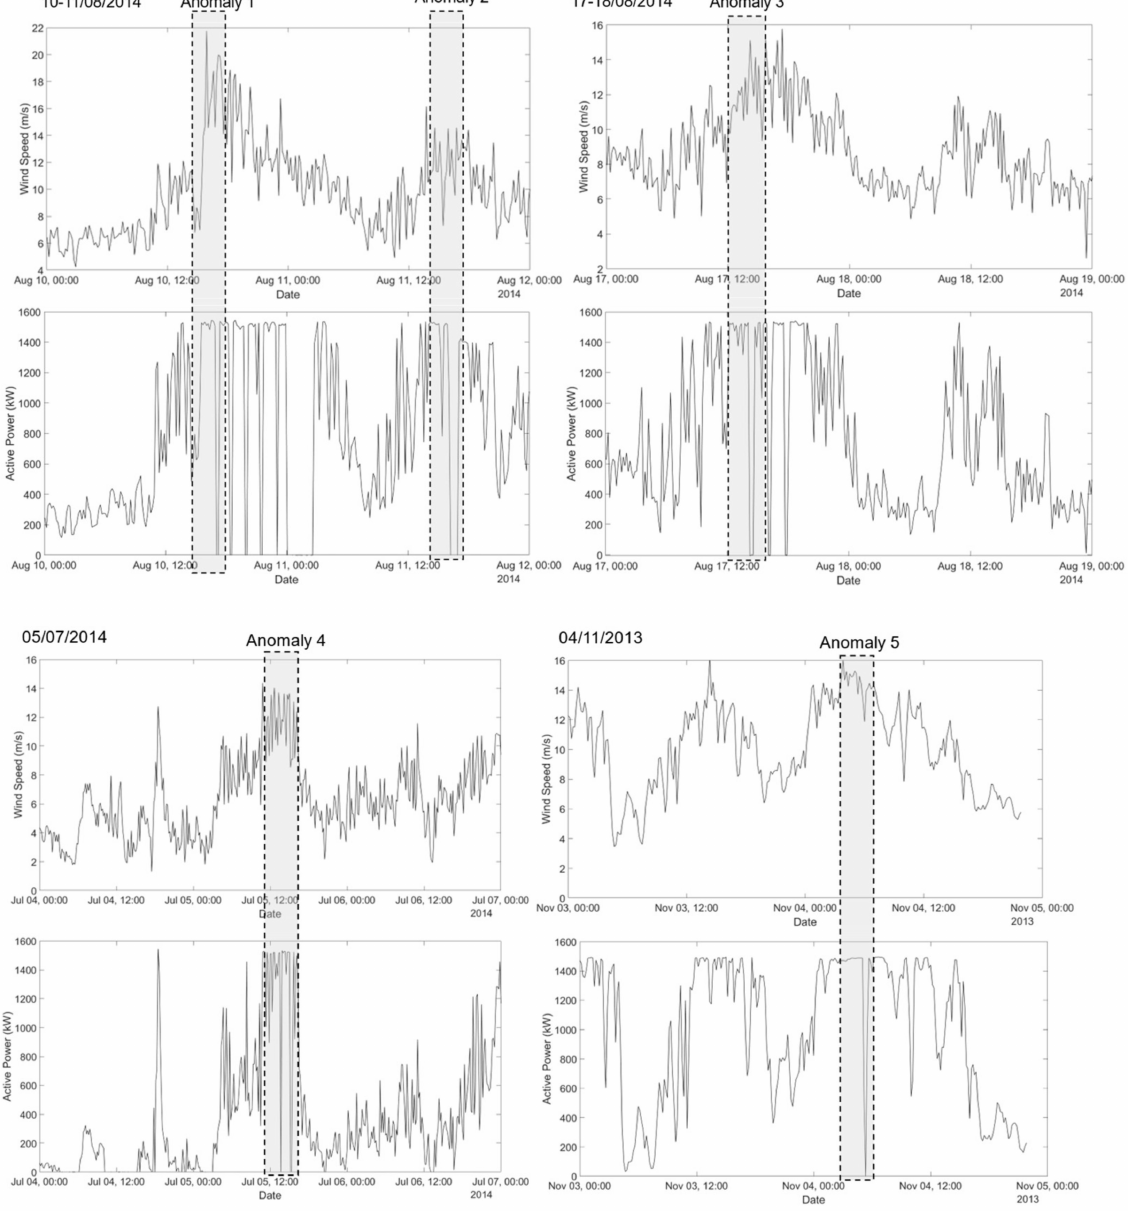
Figure 12. Five labelled anomaly cases of overcurrent during real operation (wind speed and active power